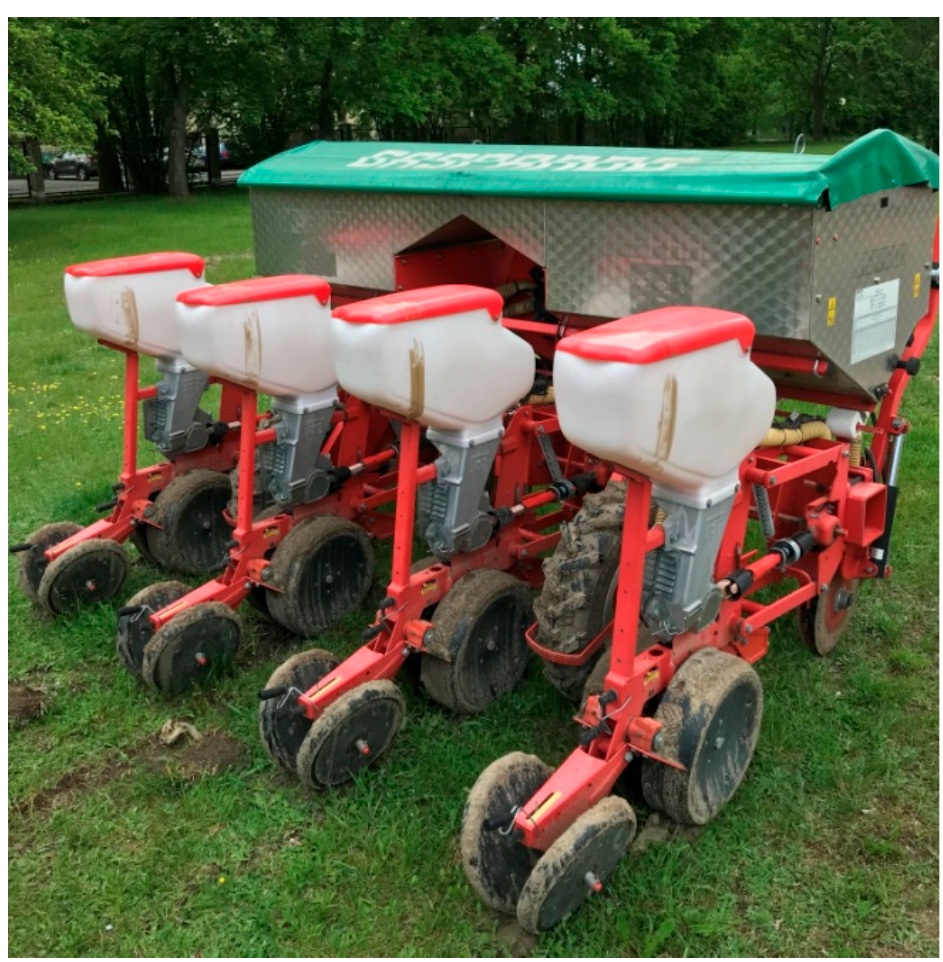
Figure 1. A fieldwork module (photo. Sosulski T.).